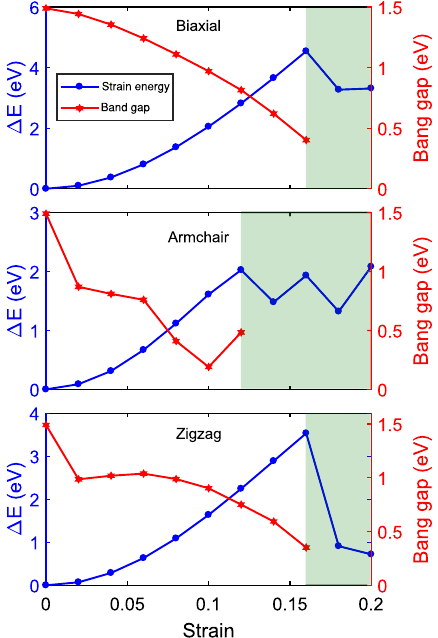
Figure 4. Variation of band gap with applied strains within the elastic